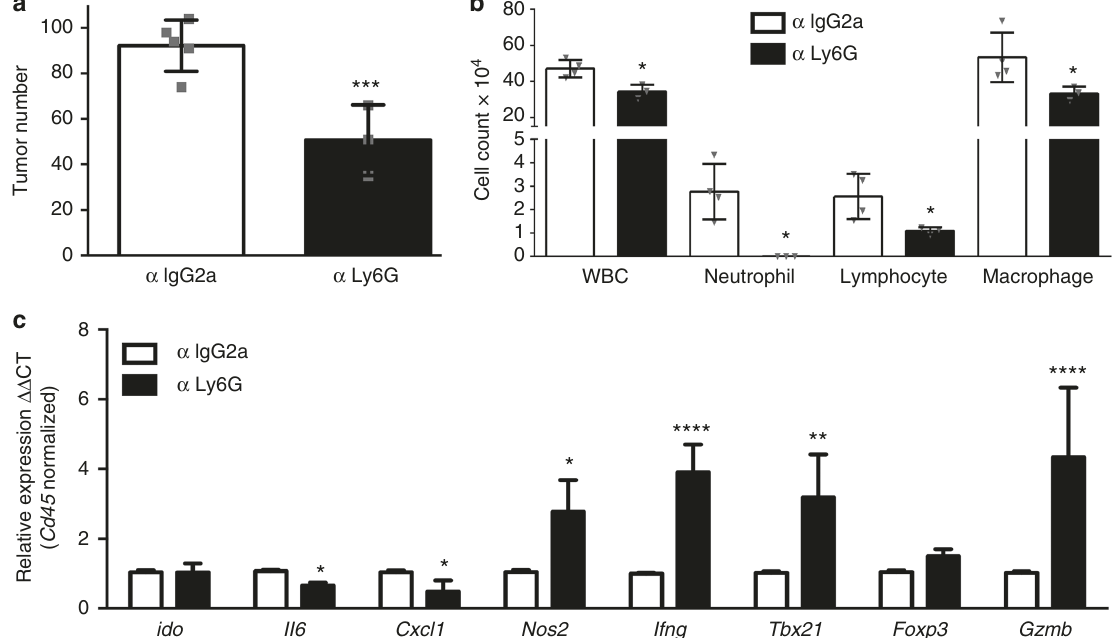
Fig. 4 Neutrophil depletion inhibits K-ras mutant lung tumors in male LR/ Stat3 Δ / Δ mice. a Lung surface tumor number in 14-week-old male LR/ Stat3 Δ / Δ mice treated with control (IgG2) ( n = 4) or anti-Ly6G ( n = 4) antibody. b Total in fl ammatory cell and lineage-speci fi c leukocyte numbers from BALF of control ( n = 4) or anti-Ly6G antibody treated ( n = 4) male LR/ Stat3 Δ / Δ mice. c Relative expression of Arg1 , Ido , Cxcl1 , Ccl2 , Il6 , Tgfb , Il17 , Tnfa , Ifng and Gzmb mRNA in whole lungs, normalized by CD45 expression, of LR/ Stat3 Δ / Δ male mice treated with control ( n = 4) or anti-Ly6G ( n = 4) antibody (data represent means± SEM; *** P < 0.001; ** P < 0.005; * P < 0.05 using two-tailed t -test, experimental replicate # 2-3). WBC, white blood cells